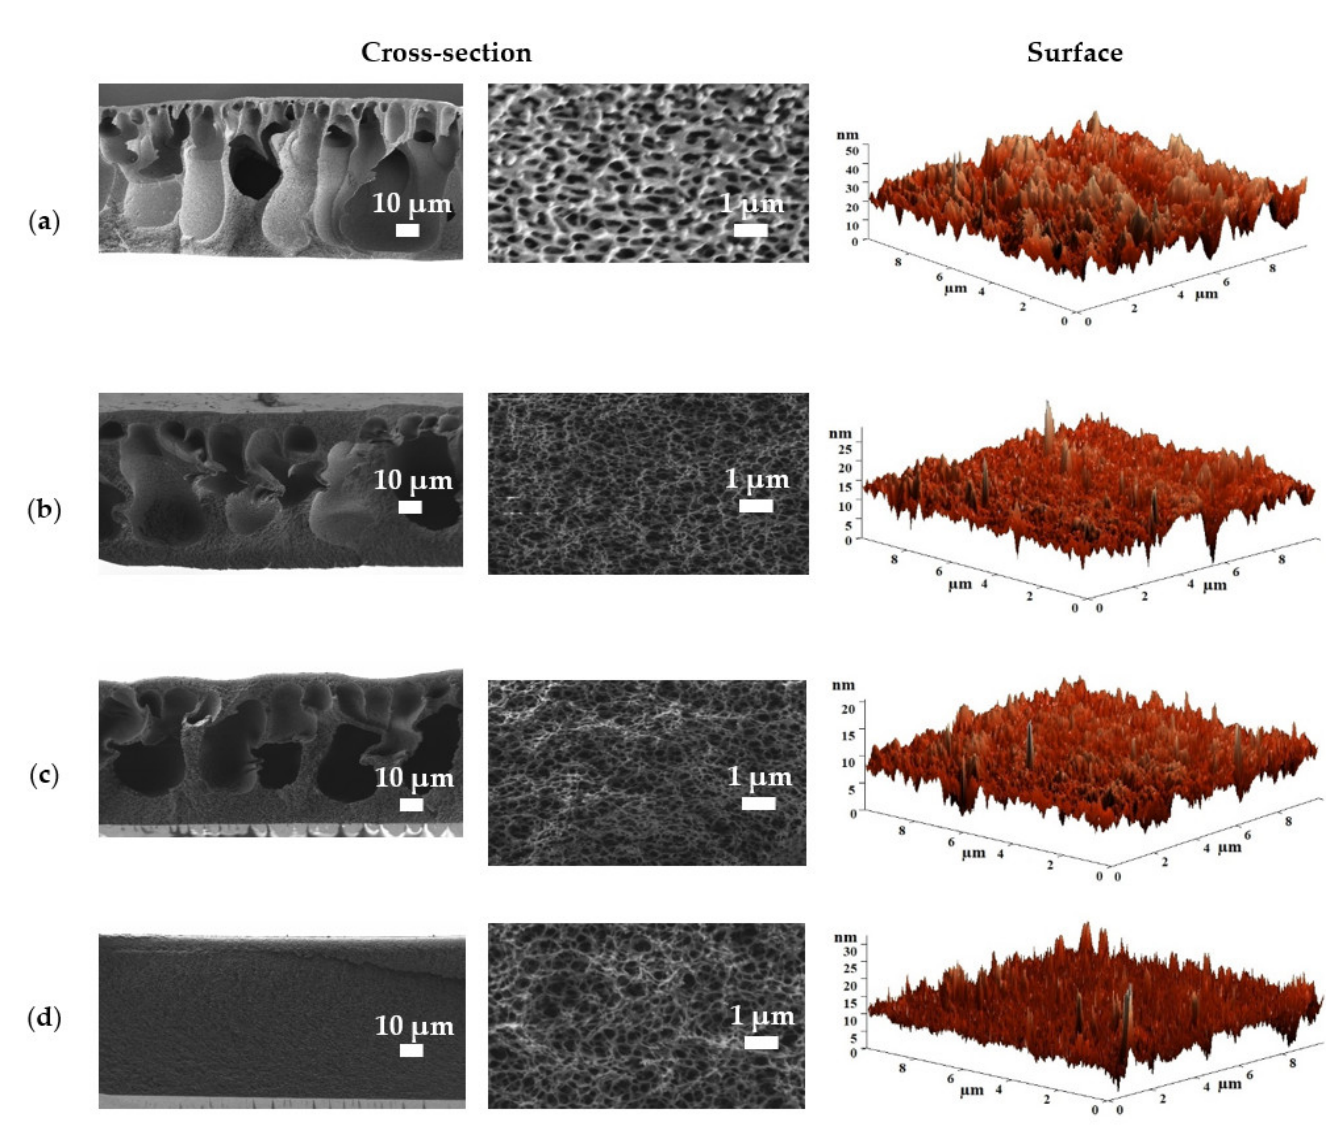
Figure 5. Cross-sectional SEM micrographs at different magnifications and surface AFM images of